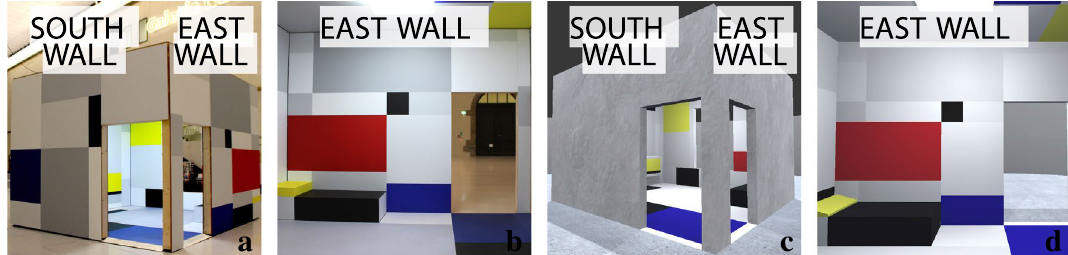
Figure 1. Physical and virtual versions of Mondrian’s room design. ( a ) The exterior and ( b ) the interior photographs of the physical installation created by artist Heimo Zobernig. Similarly, ( c ) the exterior and ( d ) the interior views of VR reconstruction, developed by our research team. In the physical installation, one of the artistic decisions of Heimo Zobernig was to extrude the interior patterns onto exterior surfaces of the room, whereas our VR reconstruction had a homogeneous grey texture for the exterior surfaces. Also note that since counterbalancing of the conditions was implemented to minimize the temporal order effects in repeated measures design, the participants were randomly assigned to view either ( a – b ) the physical installation first, or ( c – d ) the VR reconstruction